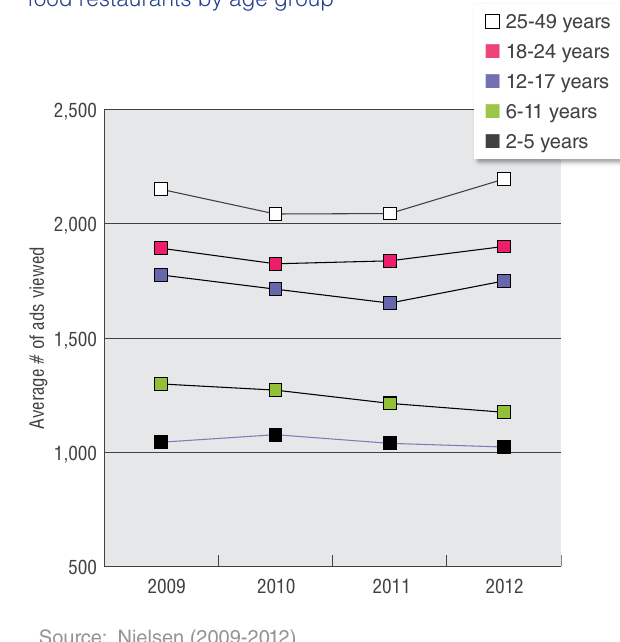
Figure 7. Trends in exposure to TV advertising for all fast food restaurants by age group